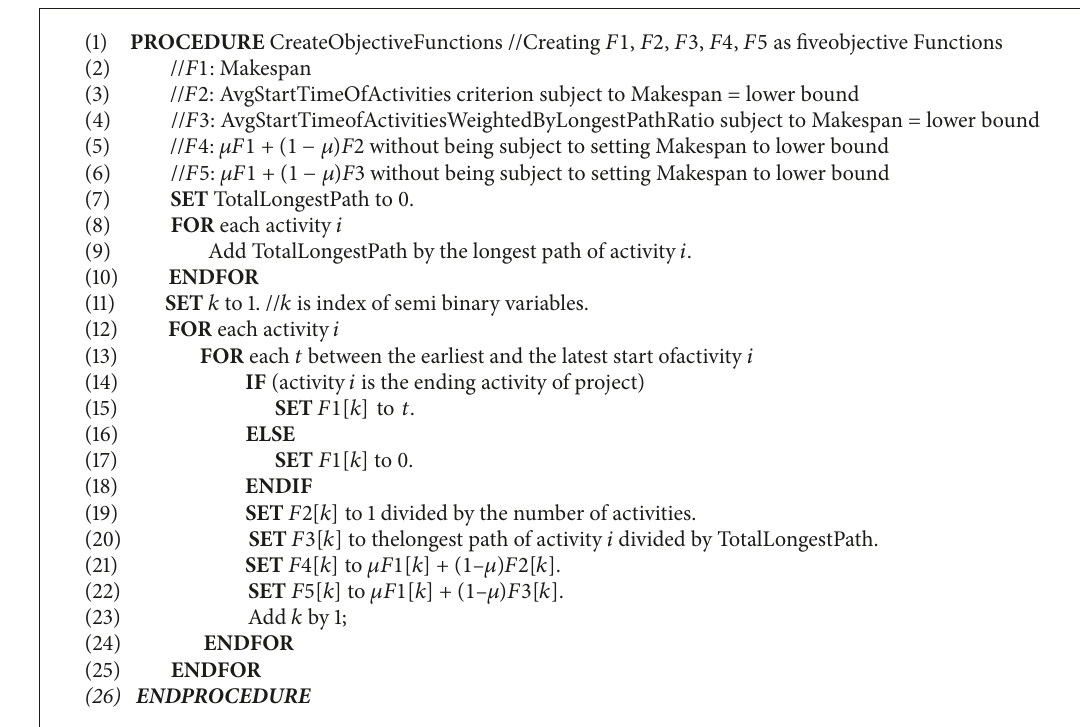
Algorithm 2: The pseudocode of the CreateObjectiveFunctions component of the